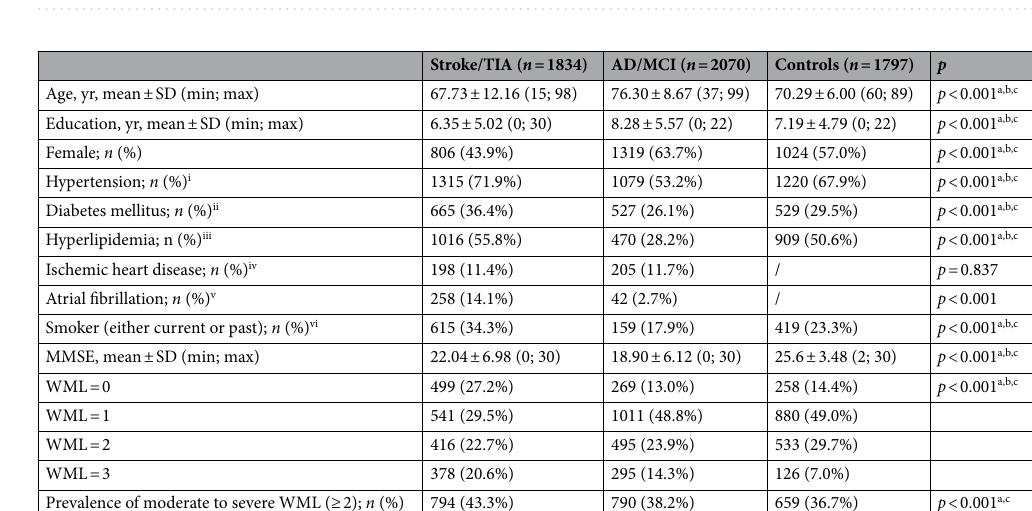
Figure 1. CONSORT diagram of the AWARE study.